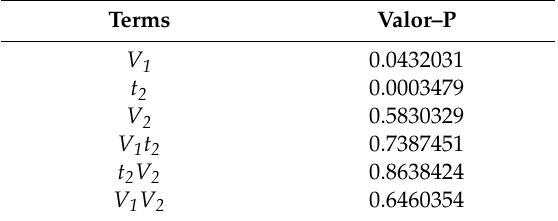
Table 7. p -Values for multivariate analysis of variance